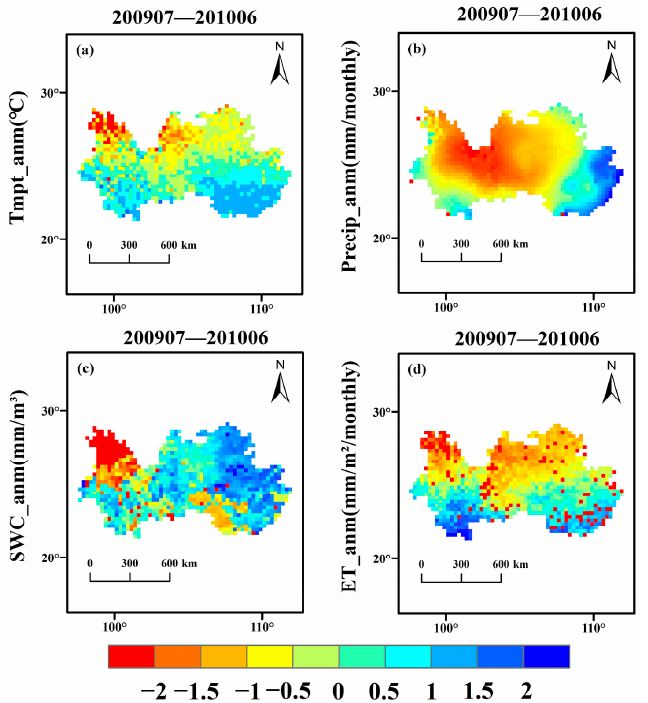
Figure 4. The spatial distributions of the anomalies of ( a ) temperature, ( b ) precipitation, ( c ) soil moisture, and ( d ) ET in three provinces in the southwest from July 2009 to June 2010.